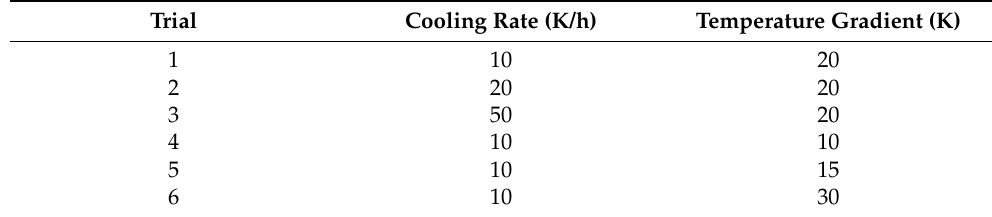
Table 3. Process parameters of the six trials.